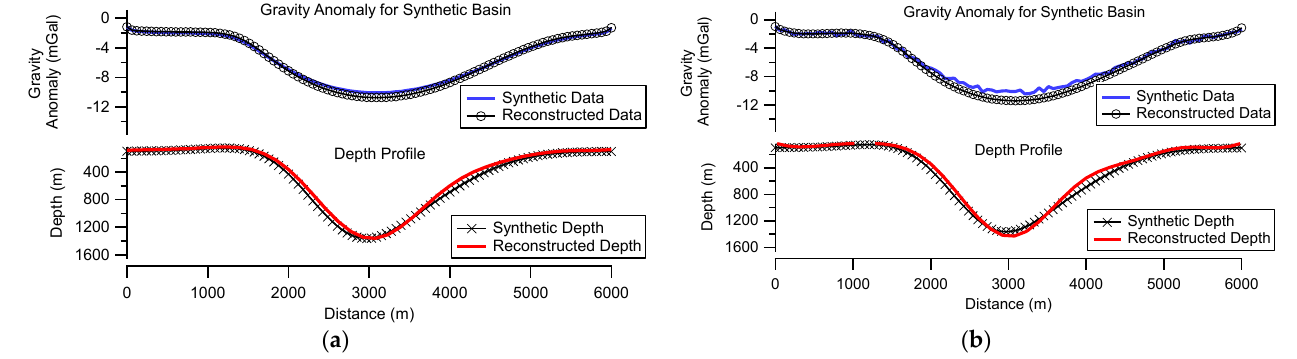
Figure 11. ( a ) Synthetic gravity anomaly model plots showing the reconstructed data and corresponding depths from the PSO computations. ( a ) A model plot without added noise, and ( b ) the model results with added Gaussian noise. The density contrast was varied between − 300 and − 385 kg/m 3 . Figure 12 displays the results from the subsequent PSO computations on the gravity data from profiles (7), obtained across the region of investigation. Seven profiles were drawn across the notable anomalies in the study area. Table 2 presents the number of parameters of the Fourier coefficients for each of the selected depth profiles. The root-mean-square error (RMSE) values of the computed gravity anomalies are also displayed.